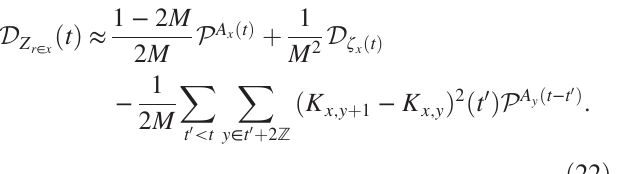
ffiffiffiffiffiffiffi p 4 π t . While